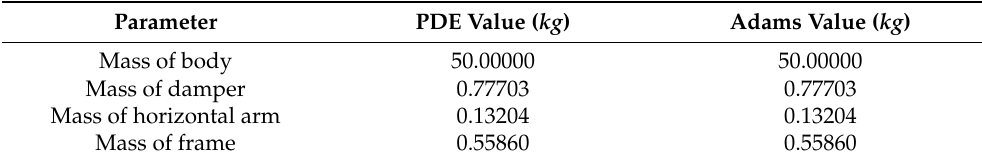
Figure 3. Adams parametric model for dynamics simulation (1. Body, 2. Frame, 3. Damper, 4. Horizontal arm, 5. Under-spring mass, 6. Ground). Table 7. Main parameters of the Adams parametric model for dynamics simulation. Table 8. Parameters of the globally optimal solution (obtained by NSGA-III) in the partial differential equation model compared with those in the Adams